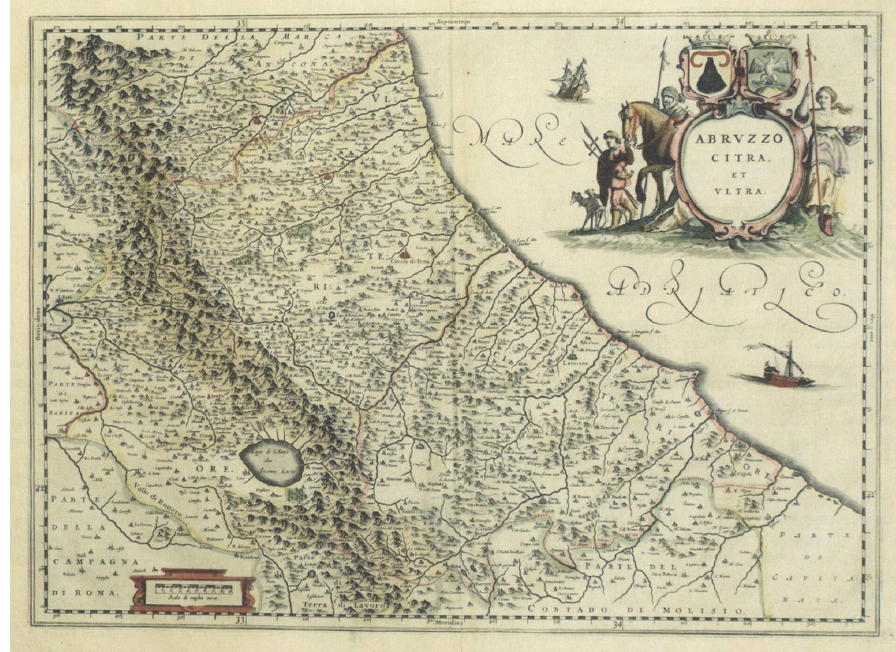
Figure 11. Joan Blaeu, Abruzzo Citra et Ultra , Amsterdam (1645), 498 × 380 mm, paper, Archives Collection of Pescara State (R. C.